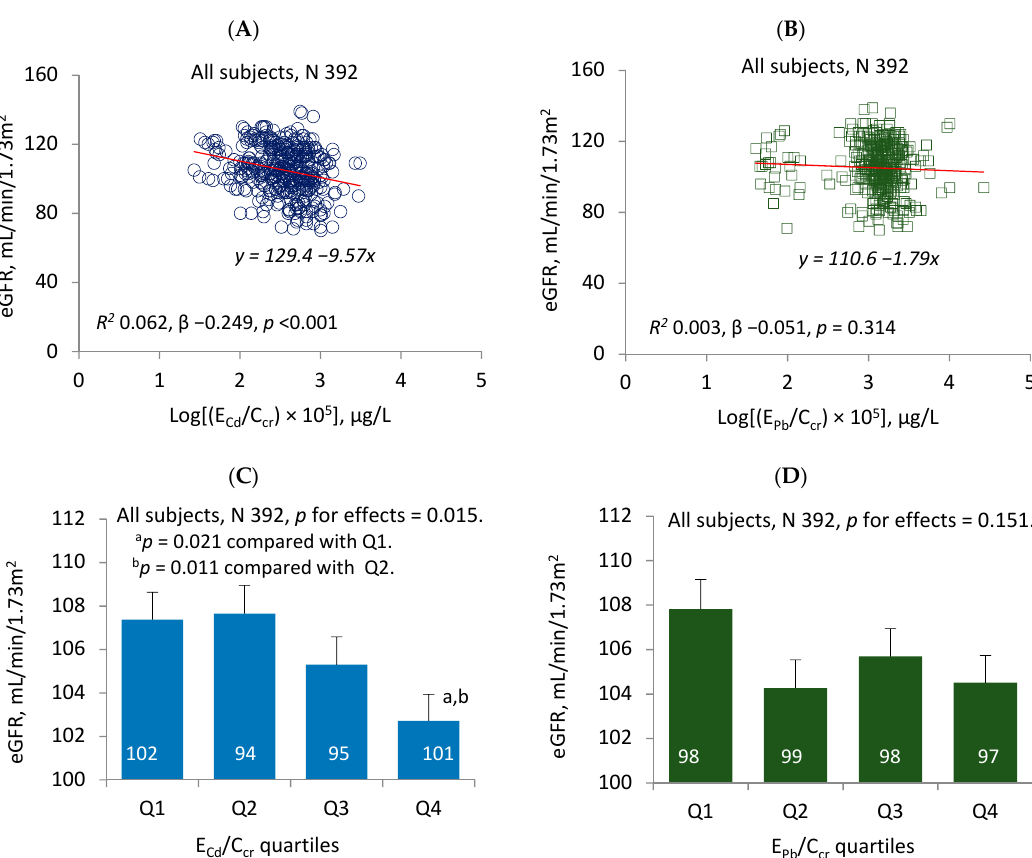
Figure 1. Comparing effects of cadmium and lead on eGFR change. The scatterplots show the relationship between the eGFR and log [excretion of Cd (E Cd )/creatinine clearance (C cr )) × 10 5 ] and between the eGFR and log [excretion of Pb (E Pb )/C cr ) × 10 5 ] in all subjects ( A , B ). The linear equations and coefficients of determination ( R 2 ) are provided together with standardized β and p -values. The bars represent the mean values for the eGFR across urinary Cd and urinary Pb quartiles ( C , D ) with adjustments for various covariates and potential interactions. The numbers of subjects are provided for all subgroups. The geometric mean (GM) values (standard deviation) for E Cd /C cr × 100 in urinary Cd quartiles 1, 2, 3 and 4 were 0.12 (0.05), 0.30 (0.05), 0.48 (0.07) and 0.88 (0.44) μ g/L, respectively. The GM (SD) for E Pb /C cr × 100 in urinary Pb quartiles 1, 2, 3 and 4 are 0.41 (0.36), 1.26 (0.10), 1.63 (0.14) and 2.73 (2.86) μ g/L, respectively.